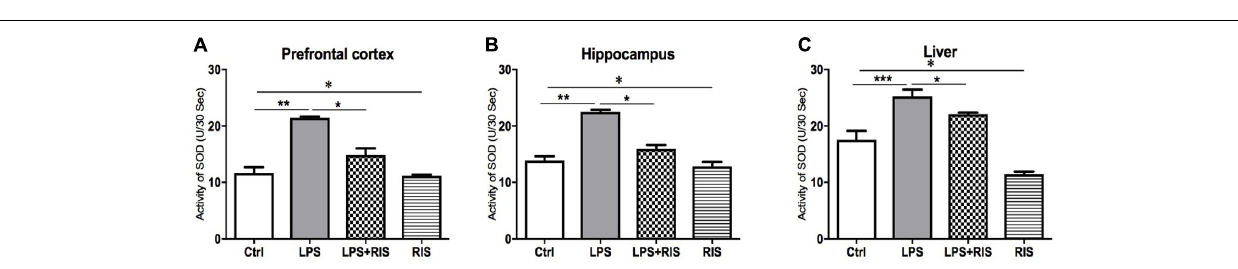
FIGURE 4 | Effect of various treatments on the activity of catalase (CAT). Groups are Ctrl (control), LPS (lipopolysaccharide), LPS+RIS (lipopolysaccharide + risperidone), and RIS (risperidone). CAT activity was measured from the prefrontal cortex (A) , hippocampus (B) , and liver (C) tissues. Values are represented as mean ± SEM. Post hoc multiple comparison test namely, “Newman–Keuls” test was used to compare between groups. n = 6 per group. ∗ p < 0.05, ∗∗ p < 0.01, ∗∗∗ p < 0.001.